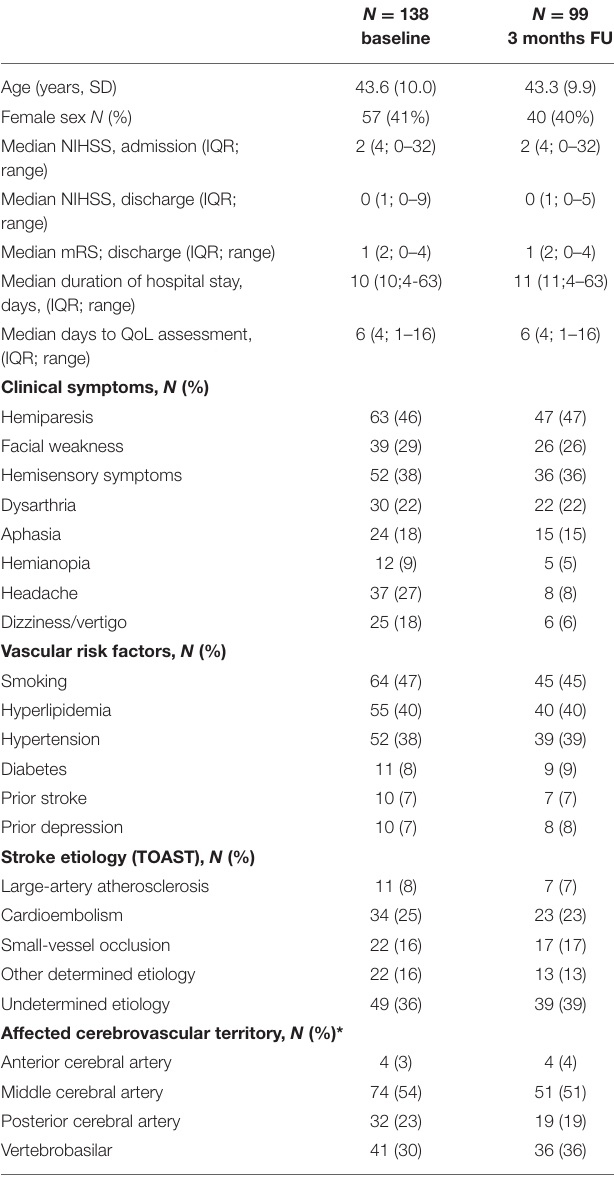
TABLE 1 | Demographics and clinical and MRI characteristics for the cohort at baseline (BL) ( N = 138) and for those with available follow-up (FU) at 3 months ( N = 99) after ischemic